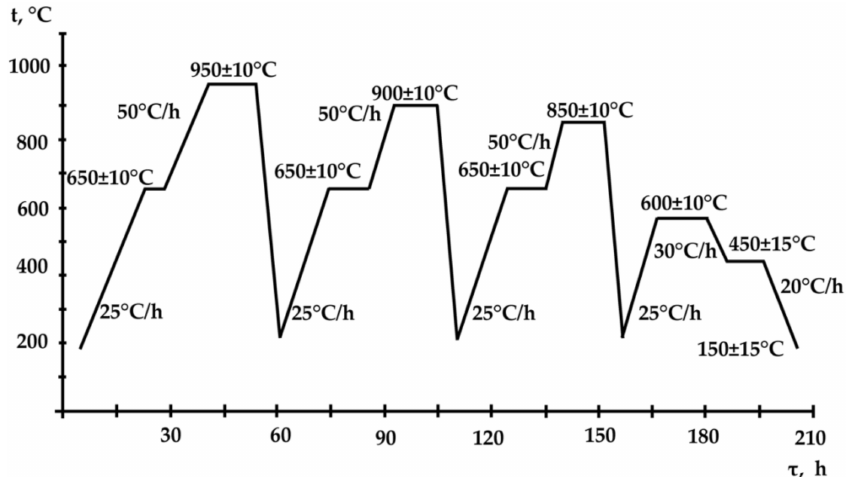
Figure 1. Mode and parameters of the triple normalizing, annealing of samples Ø200